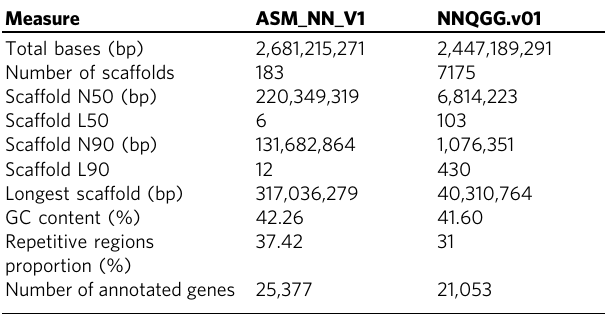
Table 2 Comparison of genome statistics of two American mink ( Neogale vison ) genome assemblies.